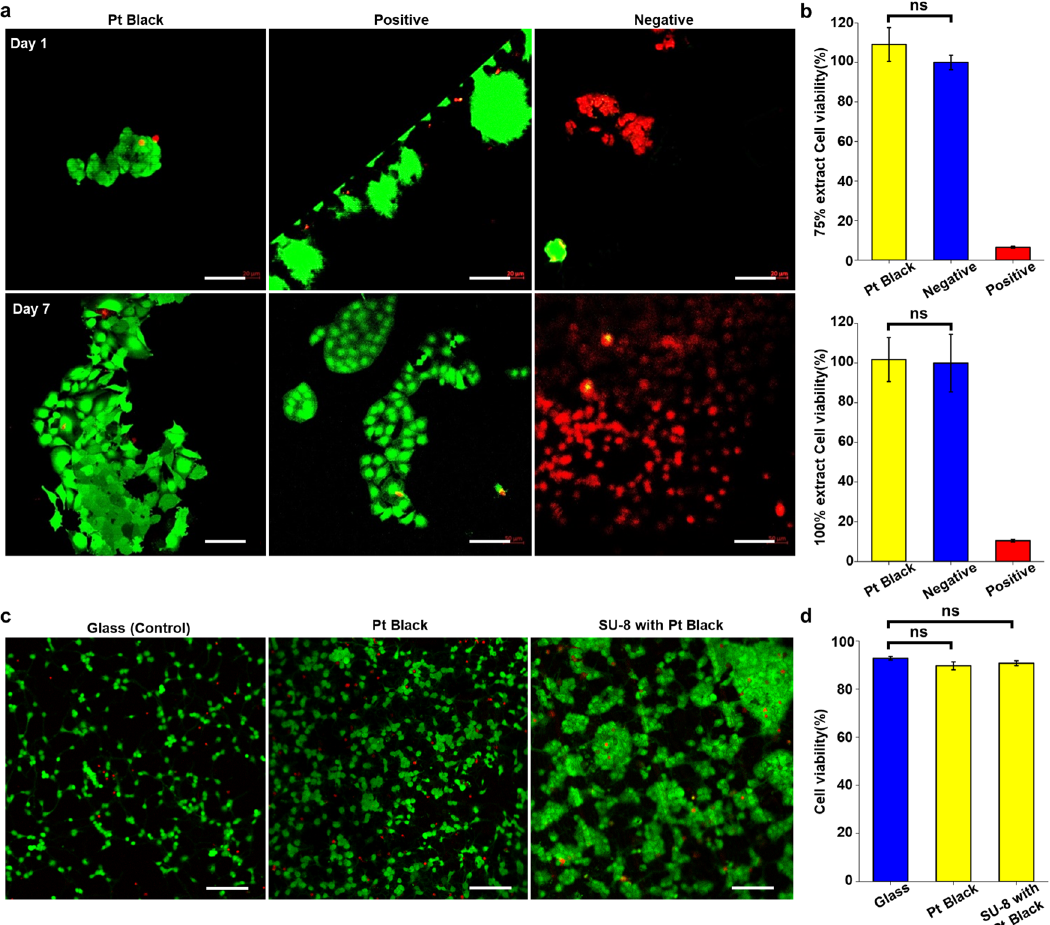
Fig. 3 Biocompatibility and cytotoxicity test of 3D electrode. a Viability of PC-12 cells cultured on the surface of Pt black electrode and glass substrates on days 1 and 7 via live/dead cells testing by laser scanning microscopy (Indicate: green (alive), red (dead)), scale bar, 50 μ m. b NIH 3T3 cells viability assay for 75% extract at the top and 100% extract at the bottom using polyethylene (PE) fi lm for negative control (blue), polyurethane (PU) for positive control (red), and Pt black electrodes (yellow) ( n = 5, n is sample number; ns P = 0.0604 (75% extract, PE vs. Pt Black), ns P = 0.8324 (100% extract, PE vs. Pt Black)). Data are presented as mean ± SD. Statistical signi fi cance was tested with an unpaired two- tailed t -test. c and d Represent the viability of neurons cultured on the three substrates (glass substrate, Pt black pattern, and SU-8 substrate with Pt black pattern). c Representative confocal fl uorescence images of live (green) and dead (red) cells stained with calcein-AM and PI on the three substrates on day 2, scale bar, 100 μ m. d The viability of the cultured neurons cultured on the three substrates on day 2, using glass substrate for the control sample (blue), Pt black, and SU-8 Pt black electrodes (yellow) ( n = 3, n is sample number; ns P = 0.0702 (Glass vs. PI), ns P = 0.0800 (Glass vs. SU-8, day 2)). Data are presented as mean ± SD. Statistical signi fi cance was tested with an unpaired two-tailed t